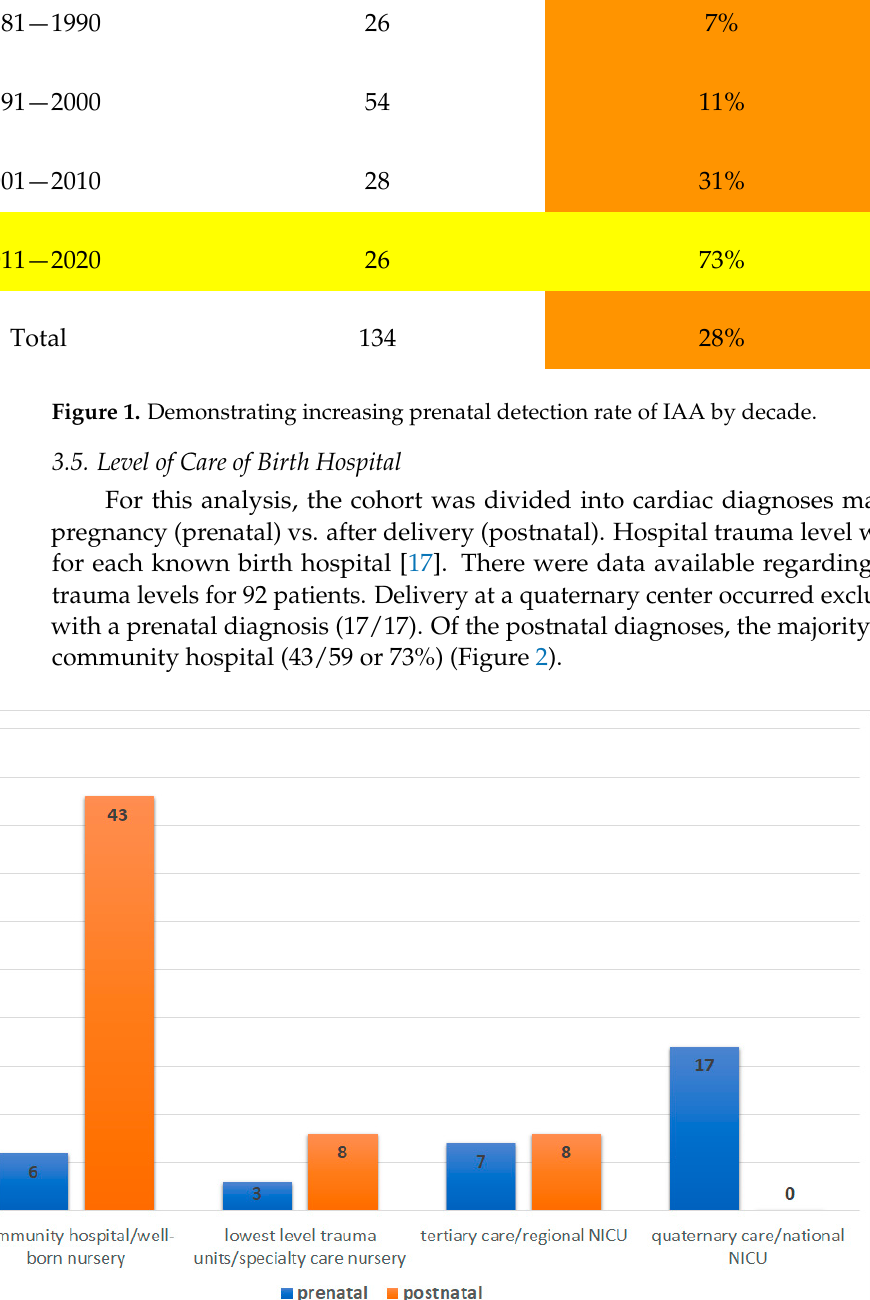
Figure 1. Demonstrating increasing prenatal detection rate of IAA by decade.